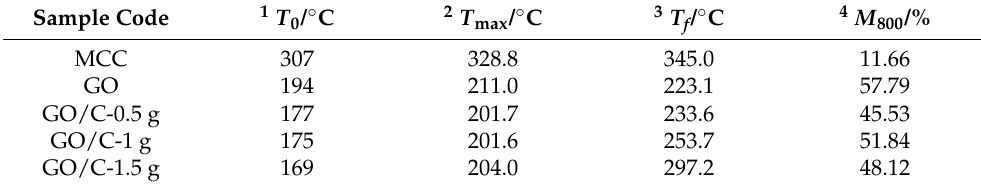
Figure 4. The TG and derivative TG (DTG) curves of the samples: ( a ) TG curve; ( b ) DTG curve. Table 2. Thermal analysis data for MCC, GO and GO/C